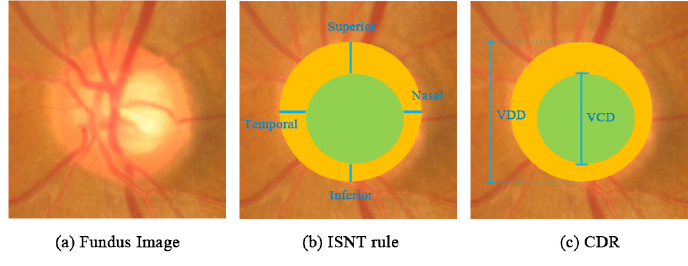
Figure 9. ( a ) The fundus image. ( b ) The green area represents the optic cup and the golden area denotes the optic disc. Here an example of ISNT rules is shown. ( c ) An example of CDR calculation is